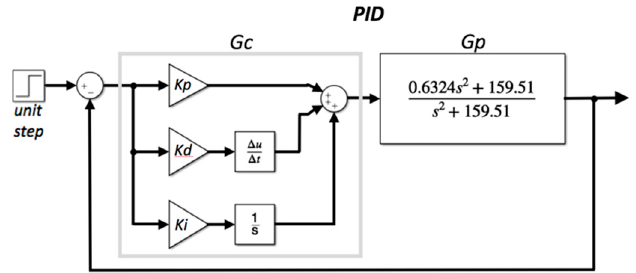
Figure8. Simulink ® blockdiagramoftheclose-loopproportional-integral-derivative(PID)control. G p is Figure 8. Simulink ® block diagram of the close-loop proportional-integral-derivative (PID) control. the plant gain with populated values, and G c is the controller gain properly tuned to reduce 𝐺 (cid:3043) is the plant gain with populated values, and 𝐺 (cid:3030) is the controller gain properly tuned to reduce undamping.